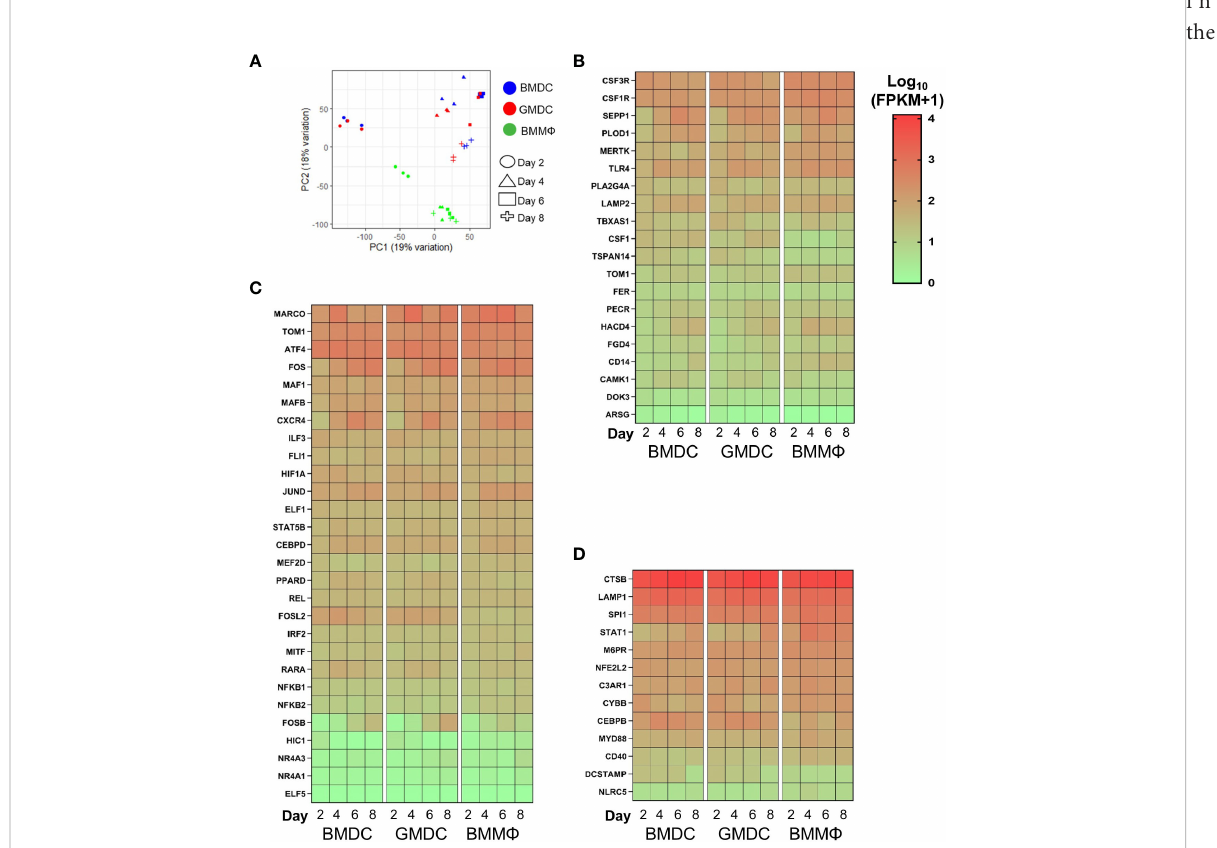
FIGURE 7 Chicken bone marrow cultures are enriched for monocyte/macrophages related gene signatures. (A) PCA of global gene expression pro fi les of BM cultures on days 2, 4, 6 and 8 of culture. Heat maps of gene expression levels of (B) core macrophage genes; (C) monocyte/ macrophages related genes; (D) myeloid effector/receptor genes and lineage related transcription factors in BMDC, GMDC and BMM F at days 2, 4, 6 and 8 of culture. Heat maps are represented as the median of Log10 transformed Fragments Per Kilobase of transcript per Million mapped reads (FPKM) values from three independent biological replicates on each day from each culture. High reads shown in red and low reads in